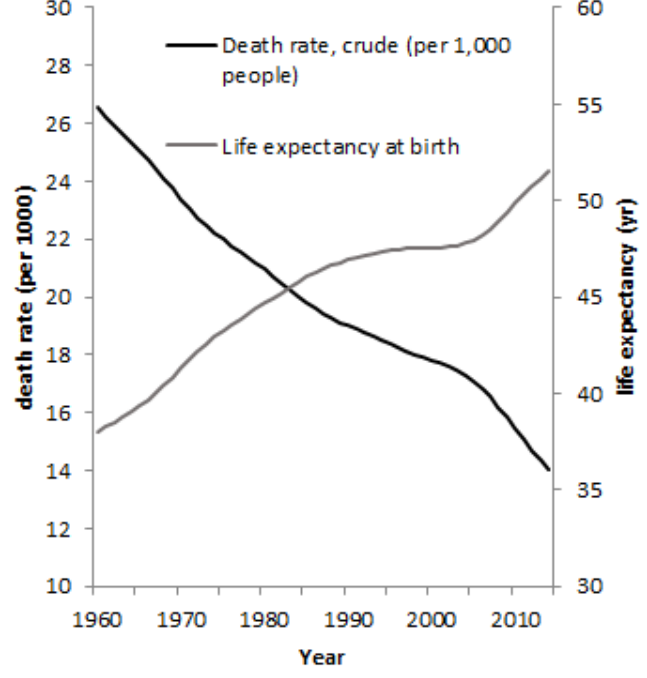
Figure 3. Life expectancy and death rate in Chad over 1960–2014. See Table 1 for source of data.